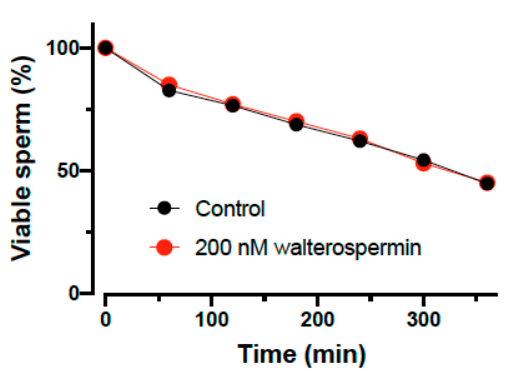
Figure 12. Percentage of viable human sperm as a function of time in the absence or presence of 200 nM walterospermin. The data were normalized to the initial level of survival of human sperm at t = 0 min.